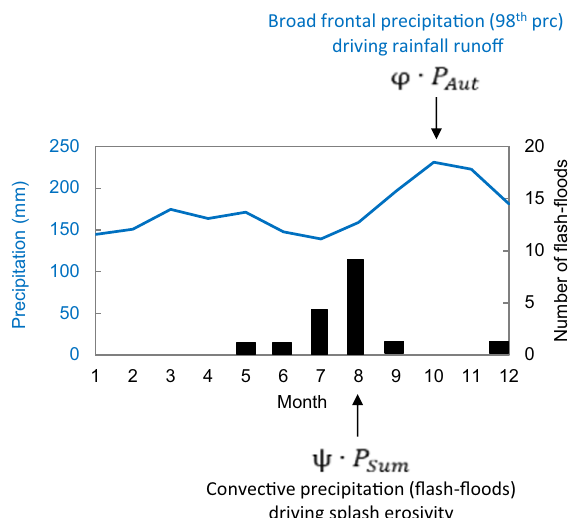
Fig. 7 Monthly precipitation (98th percentile) and frequency of fl ash- fl oods driving frontal and convective rainfall events, respectively, in Northern Italy. The number of monthly fl ash- fl oods is from Gaume et al. 125 for the period 1950 – 2006. For the same period, monthly percentiles (prc) were extracted from the CRU Global Climate Dataset 106 . The two terms of Eq. (1) are